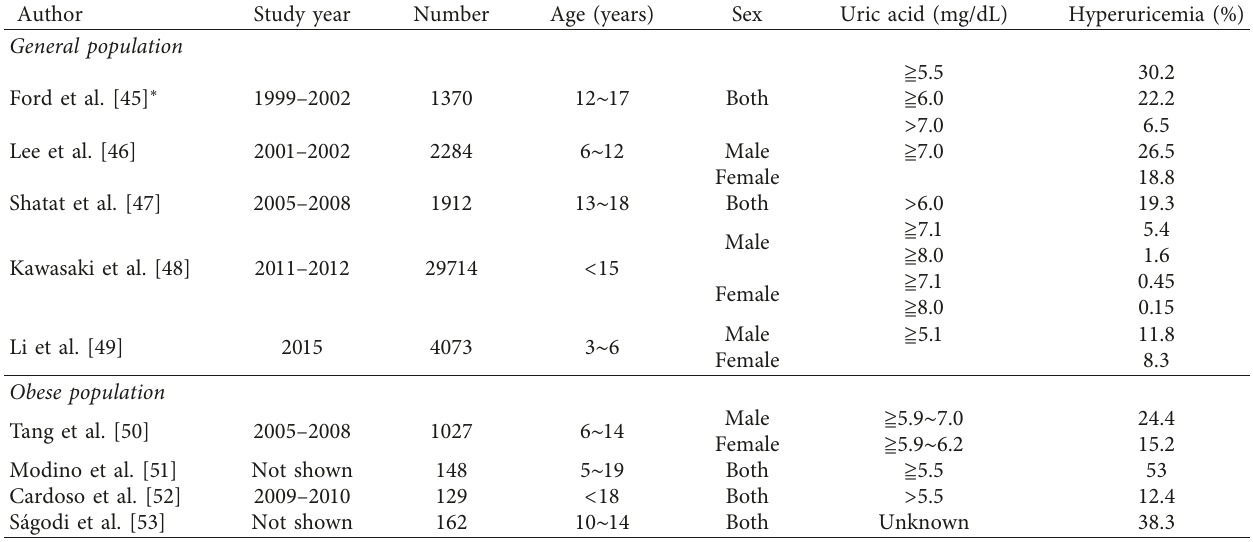
Table 3: Prevalence of hyperuricemia in a general or obese children and